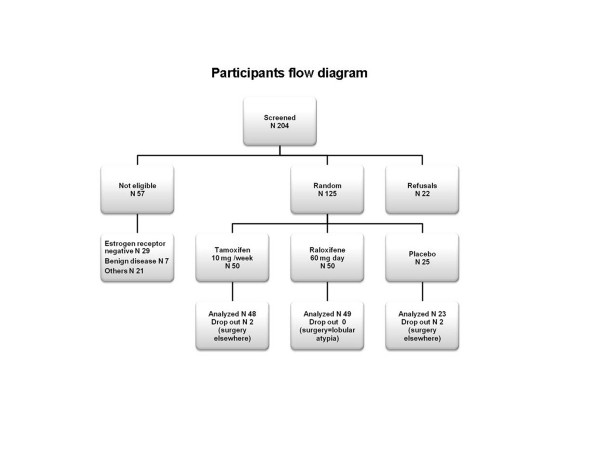
Consort statement